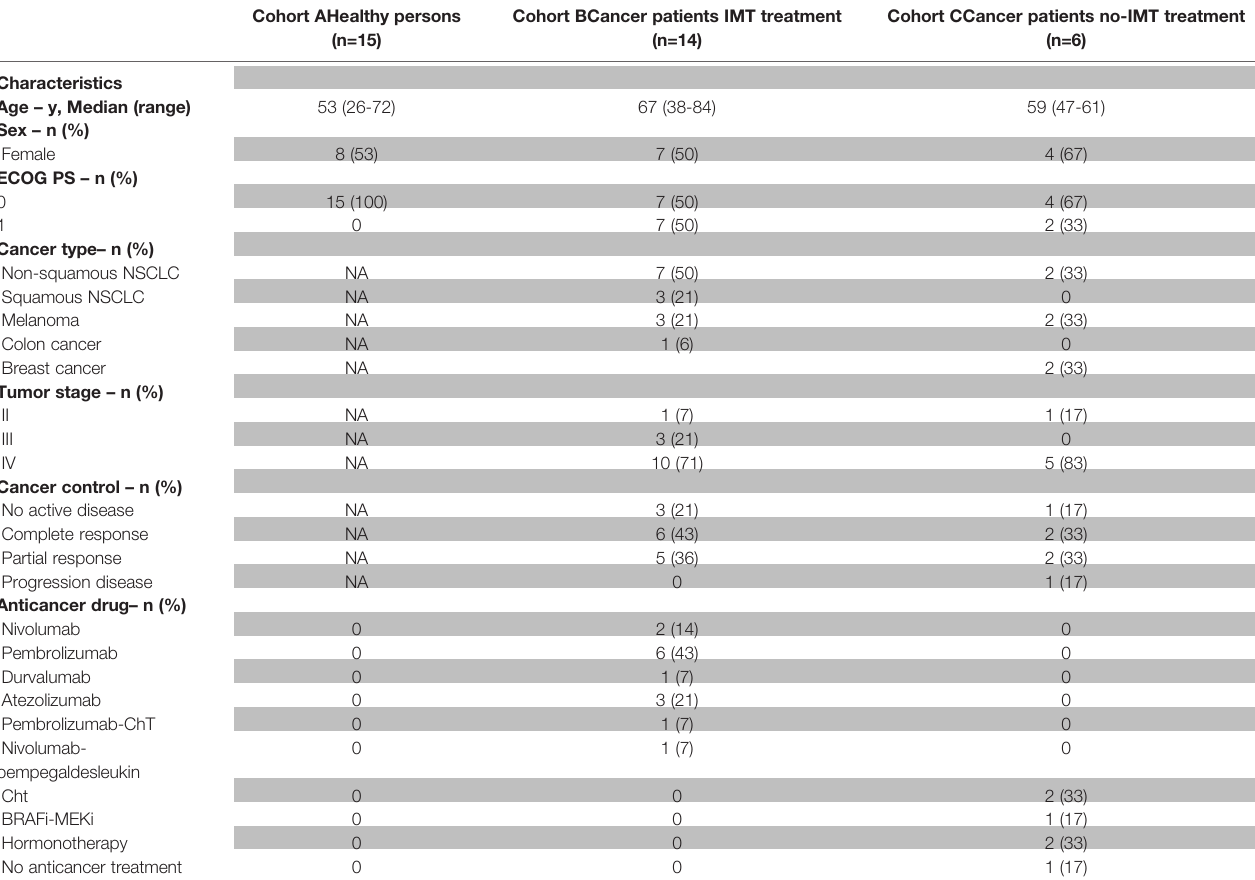
TABLE 1 | Patient